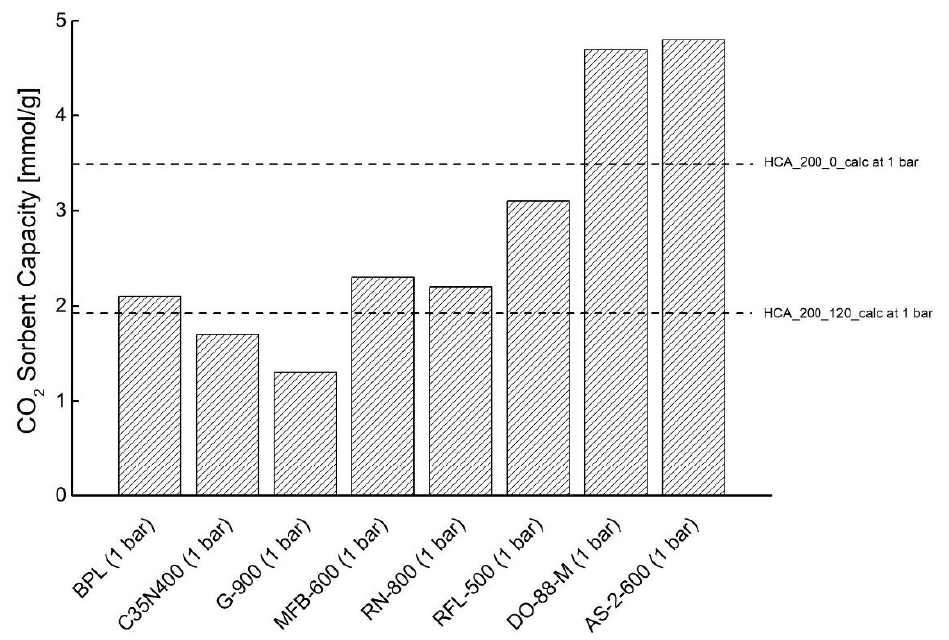
Figure 6. Comparison of CO 2 sorbent capacities with literature data obtained with batch equilibrium method (BPL: commercial activated carbon [48]; C35N400: ammonia-treated activated carbon [49]; G-900: activated graphite fibers [50]; MFB-600: N-doped activated carbon [51]; RN-800: ammonia-treated activated carbon [52]; RFL-500: N-doped porous carbon [53]; DO-88-M: activated carbon from petroleum pitch [54]; AS-2-600: sawdust-based porous carbon [40]).